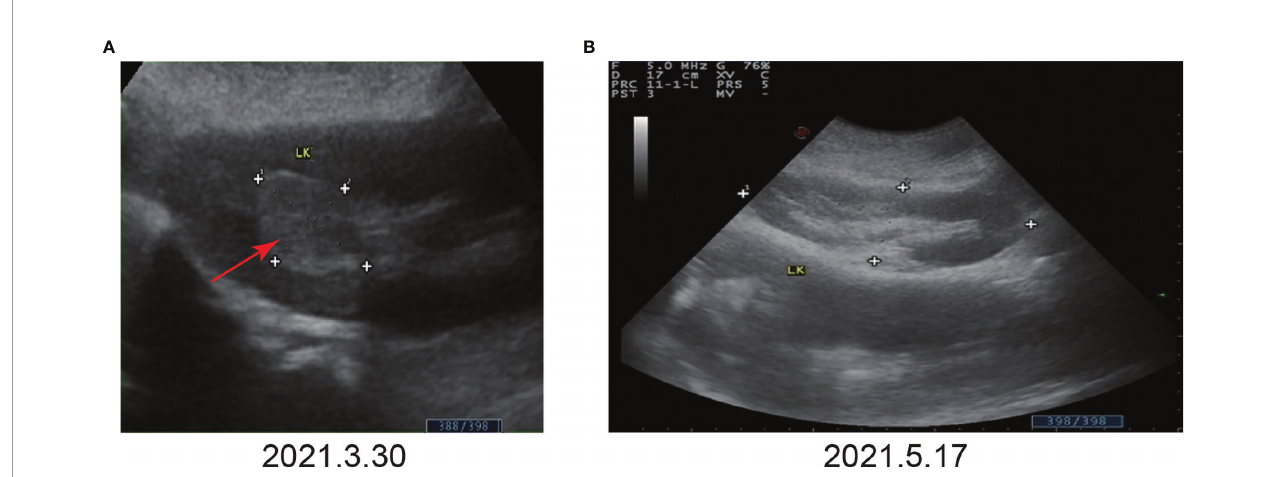
FIGURE 2 | Color Doppler ultrasound before and after immunotherapy. (A) Before immunotherapy. Color Doppler ultrasound showed a space-occupying lesion in the upper calyx of the left kidney, approximately 33 mm×24 mm. (B) After the third immunotherapy. Color Doppler ultrasound showed that no tumor was